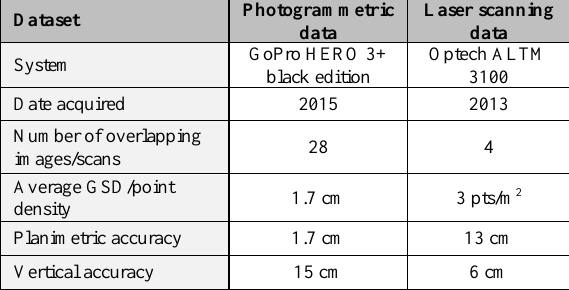
Table 1. A summary of the characteristics of imagery and laser scanning point cloud utilized in this experiment